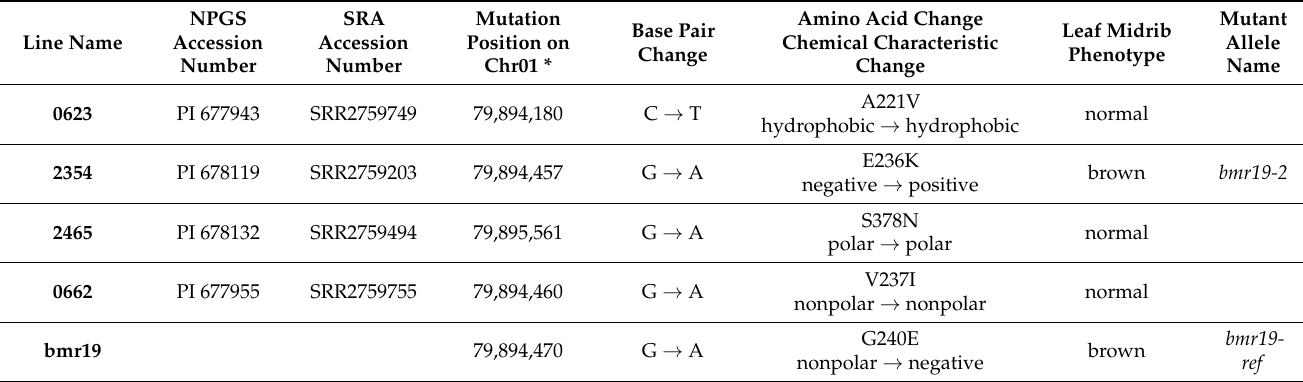
Table 2. Lines derived from ethyl methanesulfonate mutagenesis with variation in Sobic.001G535500 with respect to the reference